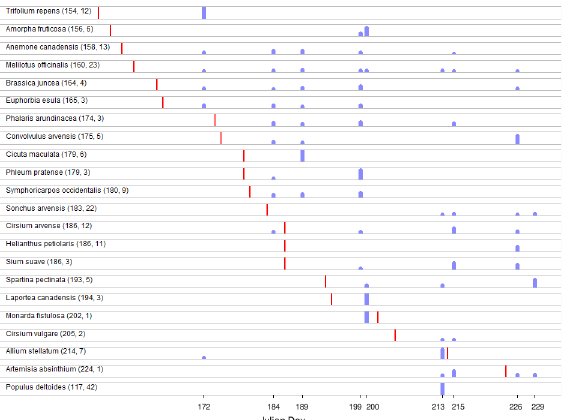
Fig 3. The proportion of total counts per million mapped reads (cpm) by sampling date for plant taxa with phenological records in [45] that overlap the range of pollen sampling dates. Red bar shows mean Julian date of first flowering from [45] relative to sampling dates (blue bars). Values in parentheses following the species name are the mean date of first flowering and the number of observations underlying that mean, respectively. Three sampling dates after Julian day 228 are omitted to avoid compressing the horizontal axis unnecessarily, as no first flowering dates occurred in that time frame for species in our sample. No red bar is shown for Populus deltoides because that mean day of first flowering is outside the range of the horizontal axis; this was also done to avoid compressing the axis.